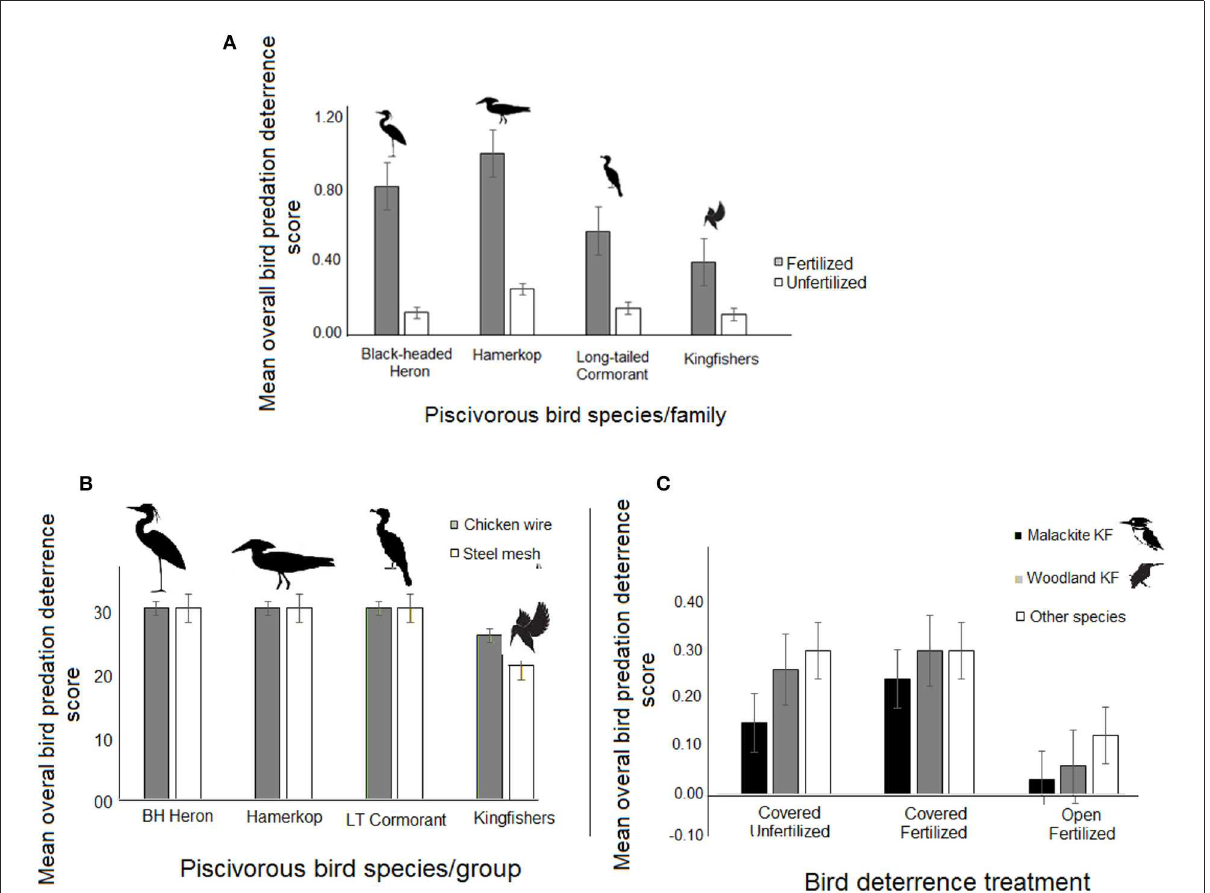
FIGURE4 (A) Relative success rate of using pond fertilization alone as a measure in deterring in predation by individual families. (B) Influence of pond cover barrier type and (C) Influence of pond cover status and enhanced fertilization on predation deterrence success against kingfishers in comparison to the other bird species. BH Heron = Black-headed heron; LT Cormorant = Long-tailed Cormorant; KF = Kingfisher. Bird deterrence scores are daily averages for the total number of days of